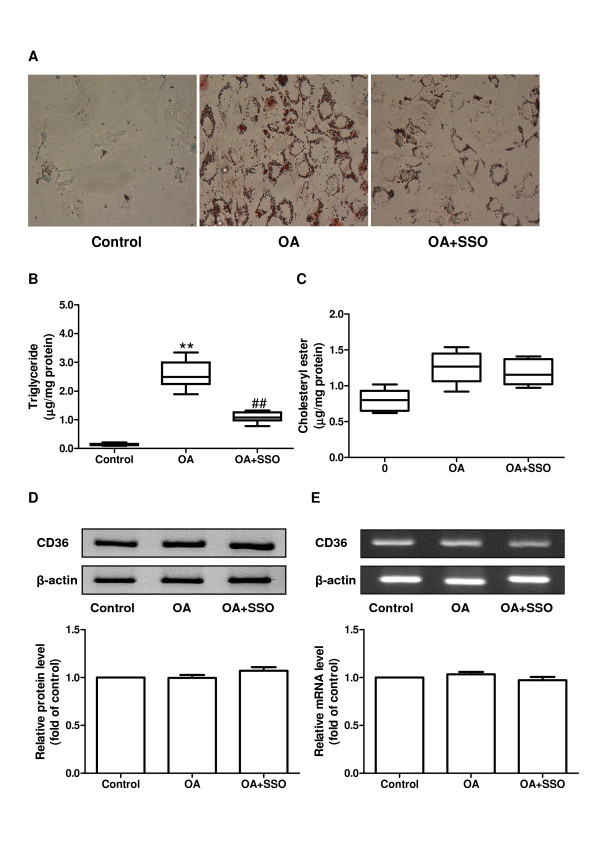
OA-induced foam cell formation is CD36-dependent. (A) Cellular lipid accumulation in rat aortic SMCs after incubation for 48 hours with vehicle (control), OA (250 μmol/L), or OA (250 μmol/L) plus SSO (250 μmol/L). Magnification ×400. Triglyceride (B) and cholesterol ester (C) levels normalized to cellular protein content in rat aortic SMCs. (D) CD36 was determined by western blotting using a specific antibody. Equal protein loading was confirmed using β-actin antibody. The graph below the blot shows quantification. (E) CD36 was determined by RT-PCR. Equal RNA loading was confirmed using β-actin primers. The graph below the blot shows quantification. Data are expressed as mean ± SEM. ** p < 0.01 compared with the control group, ## p < 0.01 compared with the cells treated with OA alone. OA, oleic acid; SMCs, smooth muscle cells; SSO, sulfosuccinimidyl oleate.